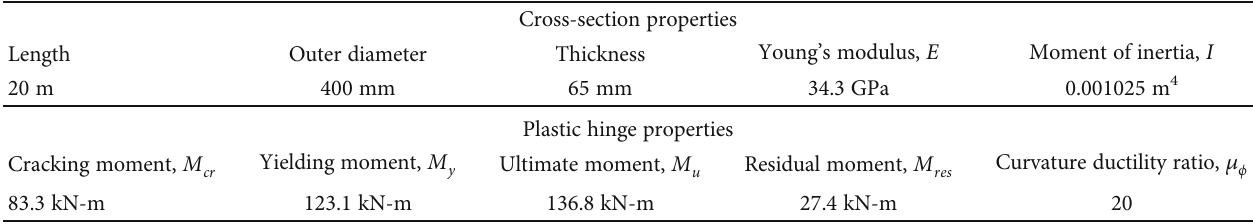
Table 3: Main analysis parameters for